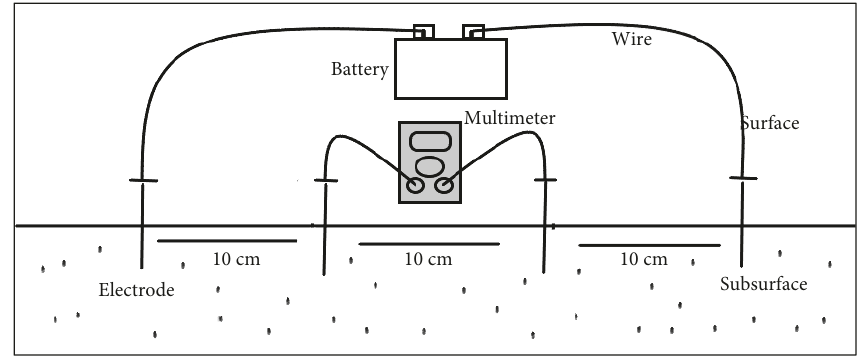
Figure 2: Wenner soil resistivity in-situ test design.